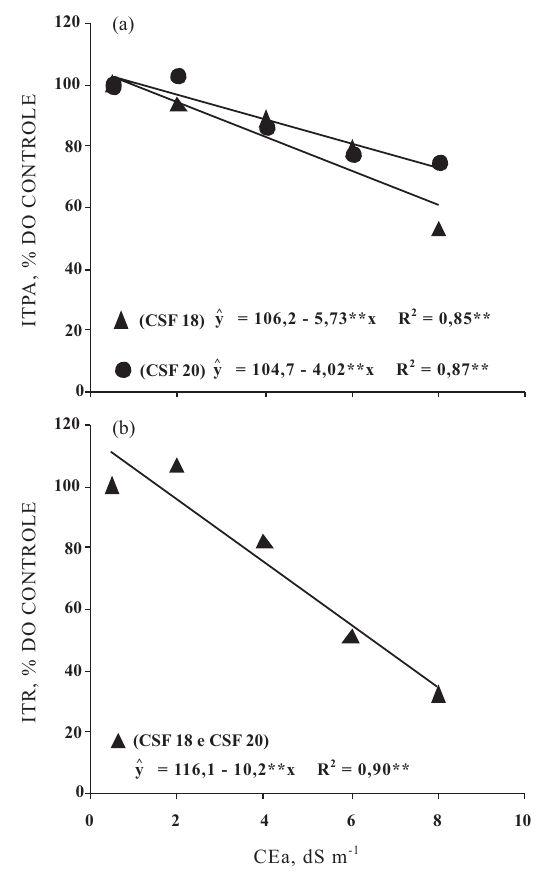
Figura 1. Índices de tolerância da parte aérea (a) e das raízes (b) de plantas de dois genótipos de sorgo forrageiro como variável da condutividade elétrica da água de irrigação